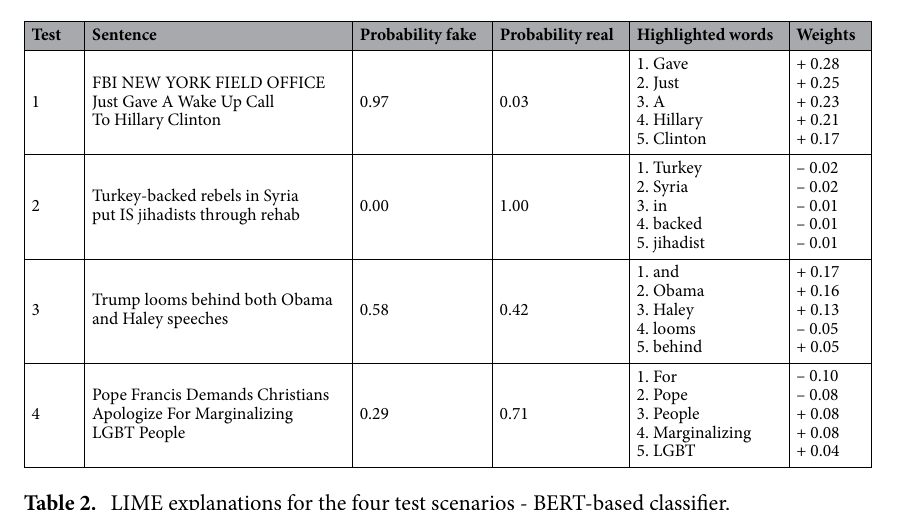
Table 2. LIME explanations for the four test scenarios - BERT-based classifier.